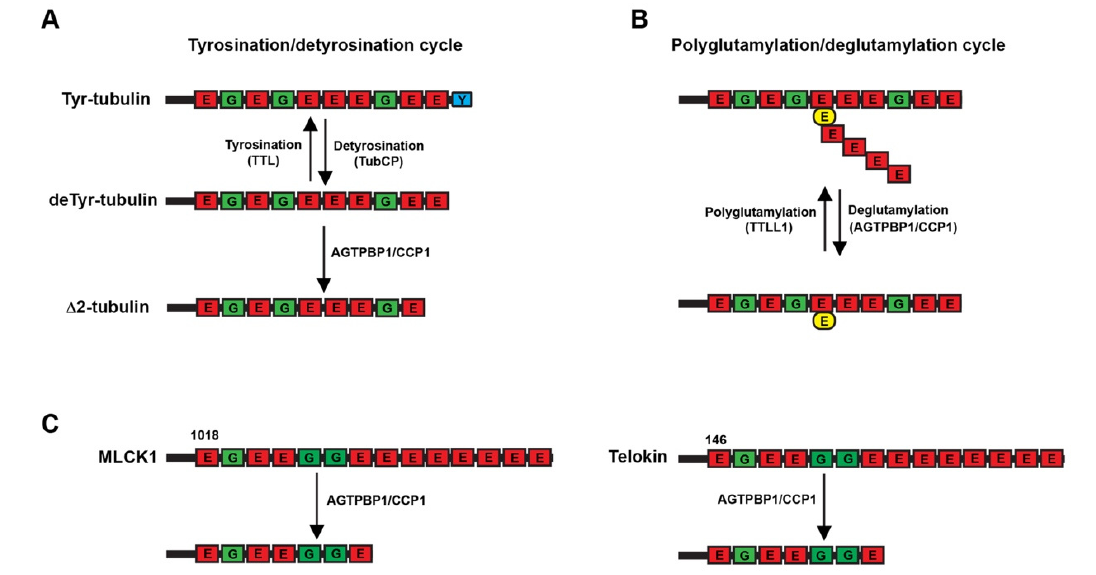
Figure 2. AGTPBP1/CCP1-mediated tubulin posttranslational modifications. ( A , B ) Schematic representation of the two AGTPBP1/CCP1-mediated tubulin posttranslational modifications. ( C ) Schematic representation of the deglutamylation of MLCK1 (left) and telokin (right) catalysed by AGTPBP1/CCP1. The numbers indicate the amino acid residues. MLCK1: Myosin light chain kinase 1. TTL: Tubulin Tyrosine Ligase; TTLL1: Tubulin Tyrosine Ligase-Like 1; TubCP: Tubulin Carboxypeptidase. Scheme is a modification of